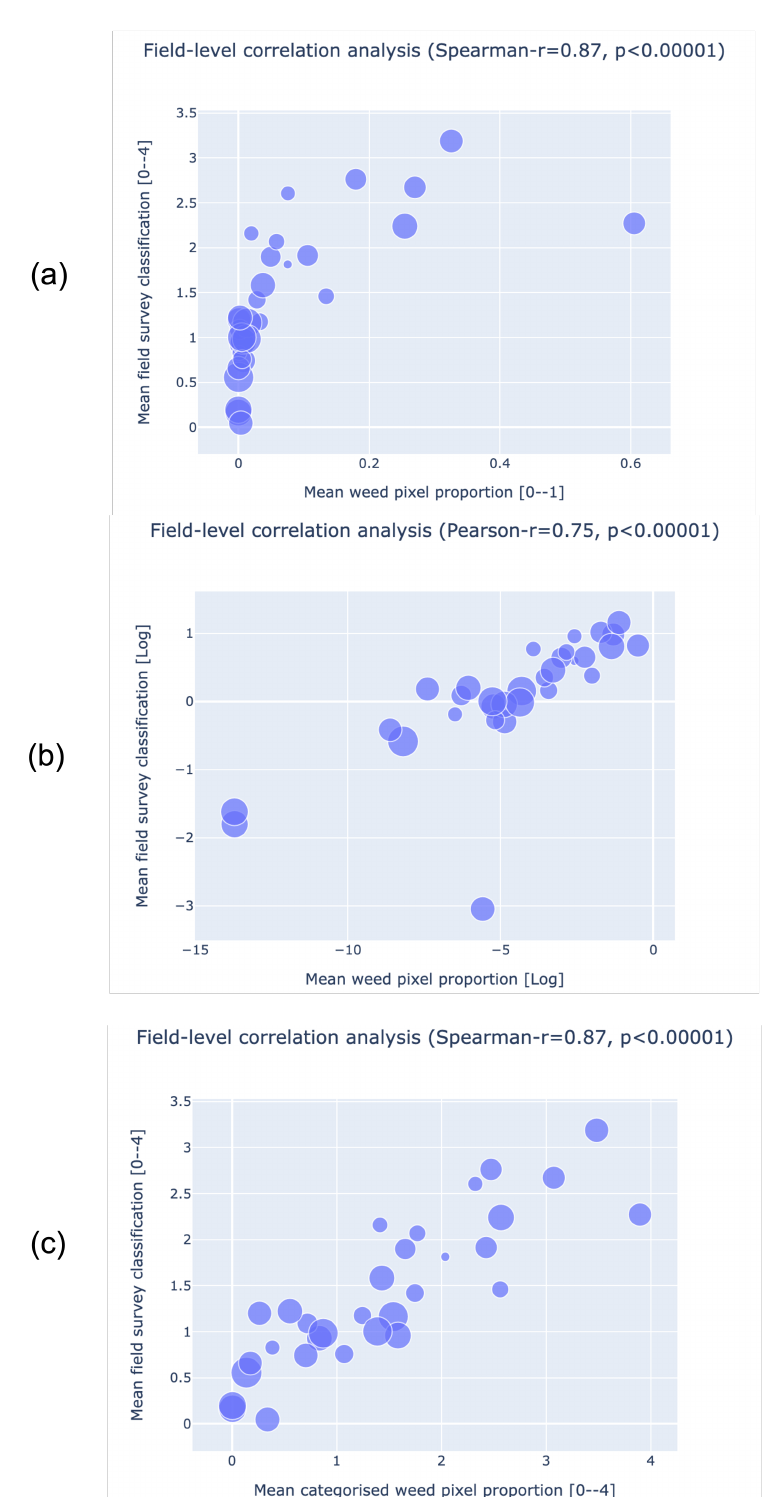
Figure 4. Field level correlation analysis (marker size indicates field size): ( a ) correlation analysis between field-level mean deep-learning weed pixel proportion in each quadrat and the field-level mean field survey data classification; ( b ) correlation analysis between the log-transformed field-level mean deep learning-derived weed pixel proportion in each quadrat and the log-trasformed field- level mean field survey data classification; ( c ) correlation analysis between field-level mean deep learning-derived weed pixel proportion derived classification in each quadrat and the field-level mean field survey data